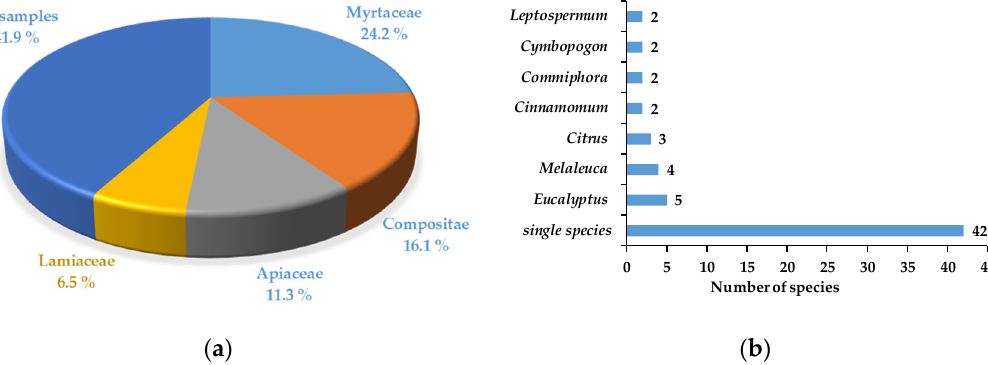
Figure 2. Plant sources of the essential oils tested against Fusarium circinatum , compiled according to ( a ) family (% of samples) and ( b ) genus (number of reported species).